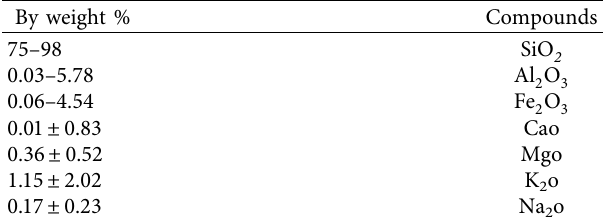
Table 6: Chemical properties of micro-silica